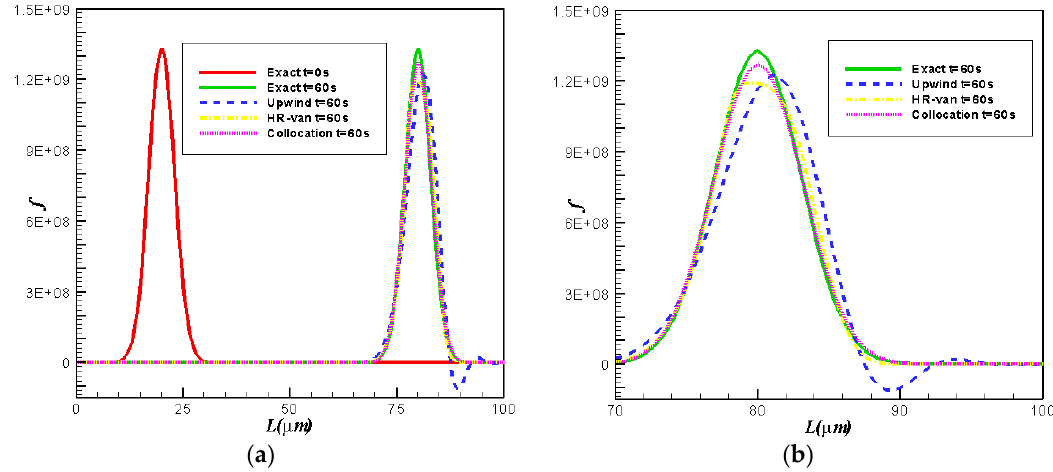
Figure 1. Comparison for final crystal size distribution (CSD) with analytical and numerical results: ( a ) in the whole crystal; ( b ) zoomed figure. Table 1. L 1 and L 2 errors for different numerical schemes.